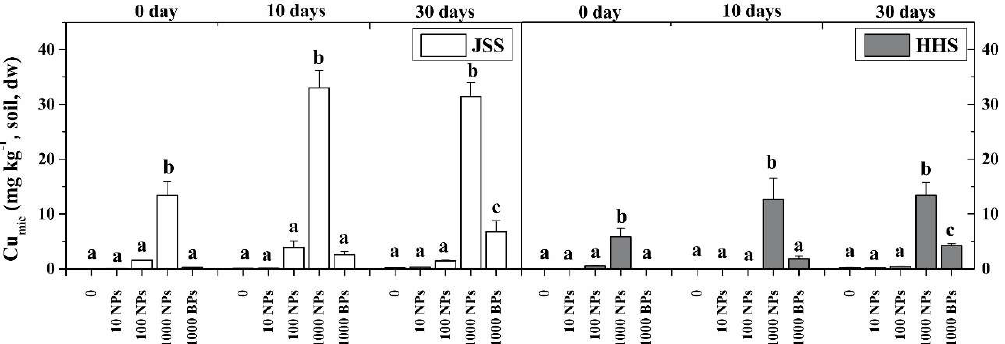
Figure 2. The available microbial Cu in two tested soils during flooding period. White: Jinshan Soil (JSS); Gray: Heihe Soil (HHS). Error bars indicate the standard deviation of the mean ( n = 3). Lowercase letters indicate the significance between the different dose exposure treatments over the same period ( p < 0.05). Table 1. Fitting results of the Cu XANES spectra of soil samples exposed to 1000 mg/kg CuO NPs using a linear combination of the data for model